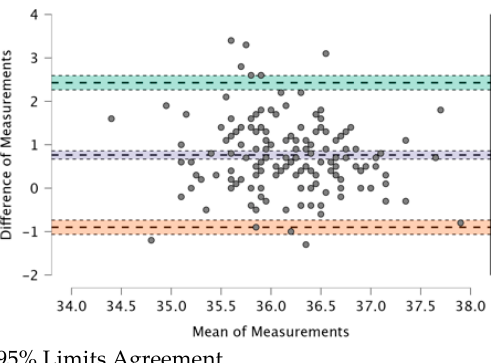
Figure 1. BT–Non-Contact Tympanic Infrared TM and BT–Axillar Electronic TM.